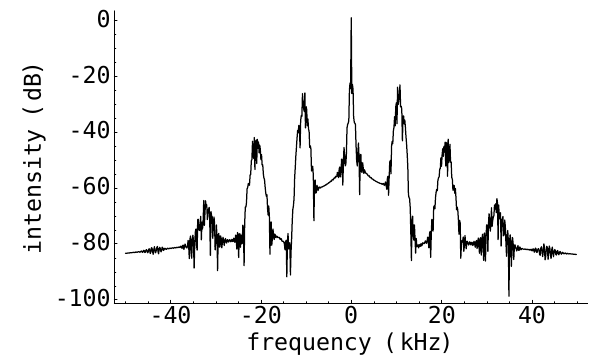
FIG. 16. Simulated spectrum about the 135th revolution har- monic of a 200 mA fully stretched weakly unstable bunch. The ring impedance consists of main-cavity and harmonic-cavity fun- damental rf modes. Their tunes are realistically adjusted for beam-loading compensation. Machine parameters are given in Table I.